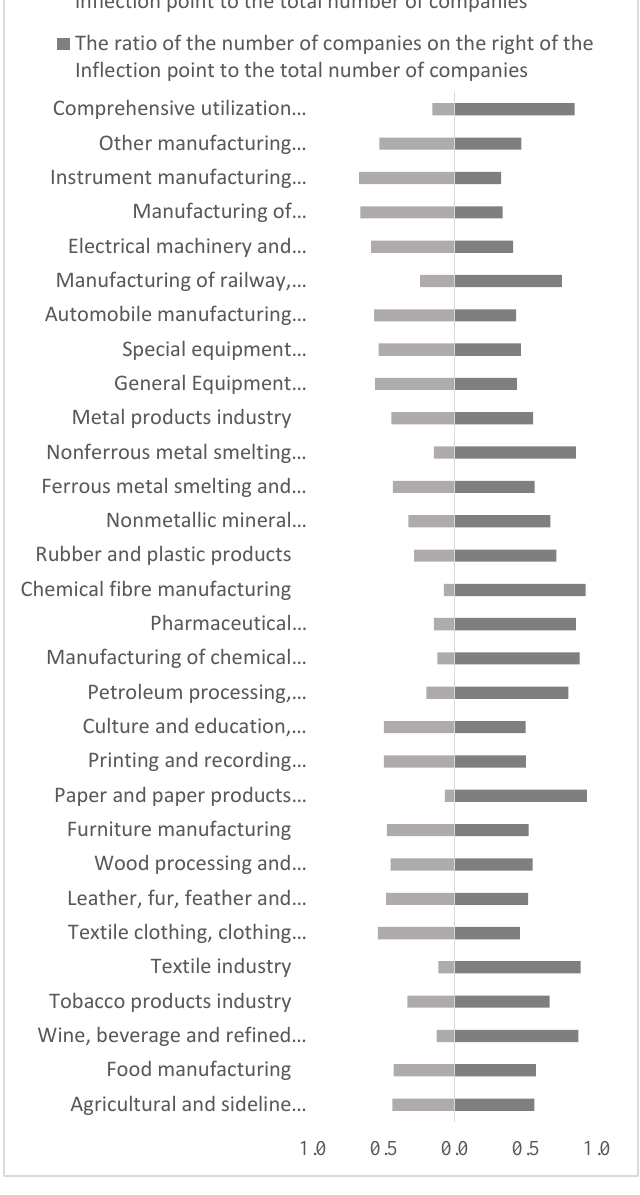
Figure A1. The ratio of the number of enterprises on both sides of the environmental compliance inflection point to the total number of enterprises in China’s binary code industry.